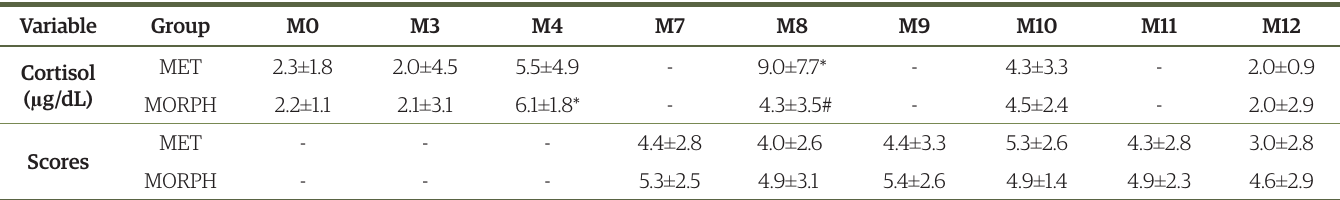
Table 3. Medians and interquartile deviations of the concentration serum cortisol and means and standard deviation of the analgesia scores in female dogs maintained under epidural analgesia with methadone (MET), 0.3 mg/kg, or morphine (MORPH), 0.1 mg/kg, and anesthesia with isoflurane, and submitted to